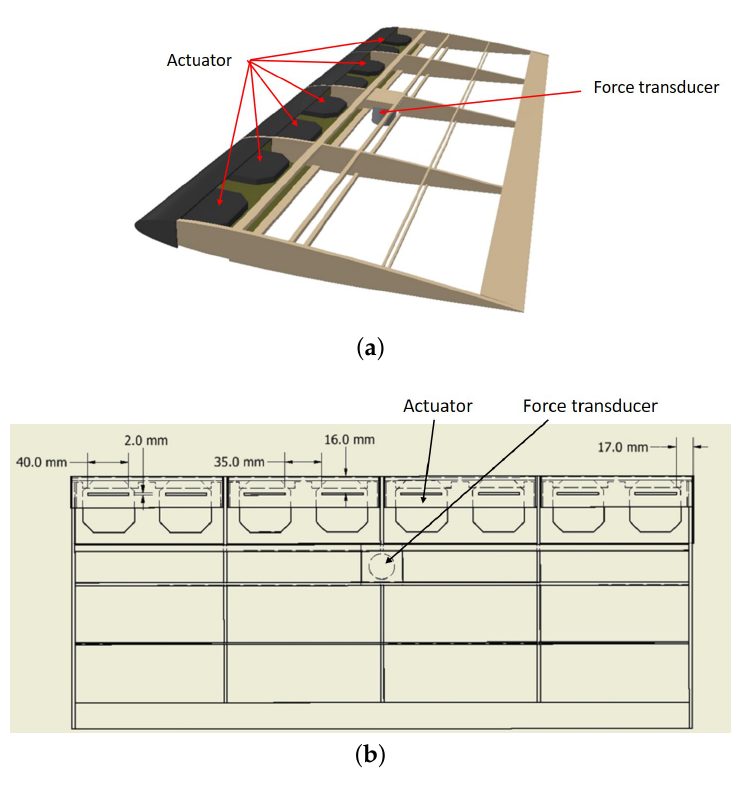
Figure 1. The schematic of NACA0009 wing and the actuators: ( a ) an angled view of the wing; ( b ) the top view of the wing.